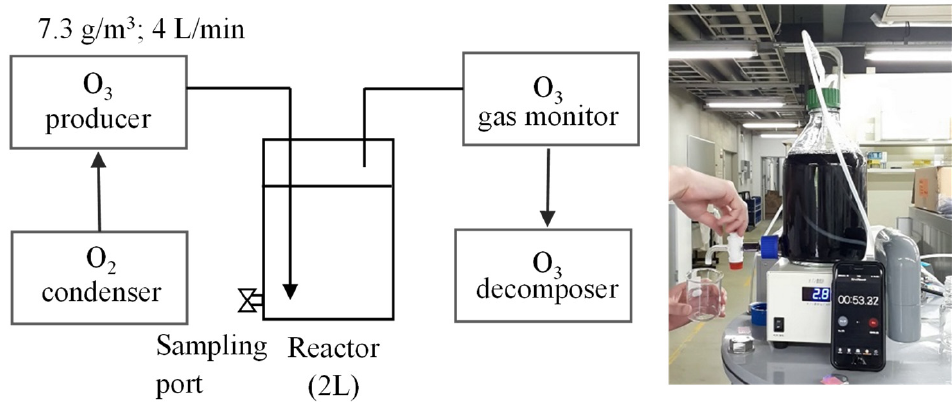
Figure 1. Schematic of the ozonation reactor used for synthetic batik